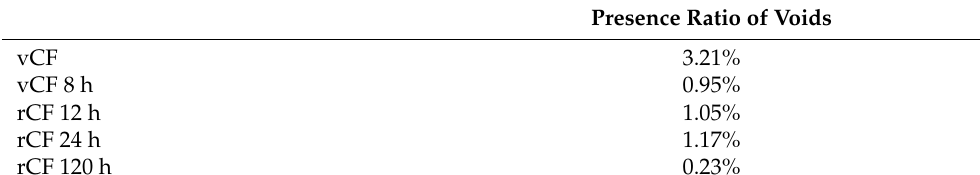
Figure 7. Results of TEM image of the cross-section for ( a ) vCF, ( b ) vCF 8 h, and rCF ( c ) 12 h, ( d ) 24 h, and ( e ) 120 h.